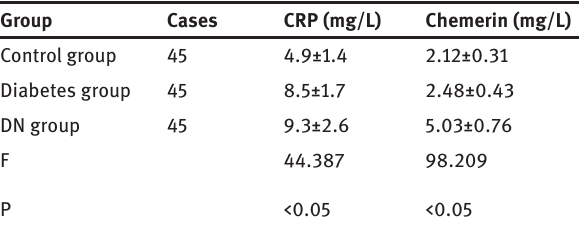
Table 2: Comparison of serum CRP and the level of chemerin between the patients in three